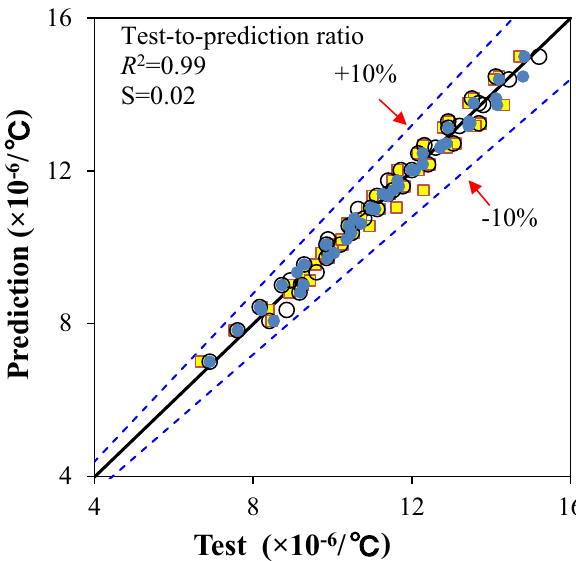
Fig. 7 Comparisons of transit linear thermal expansion coef- ficient a t between tests and predictions.